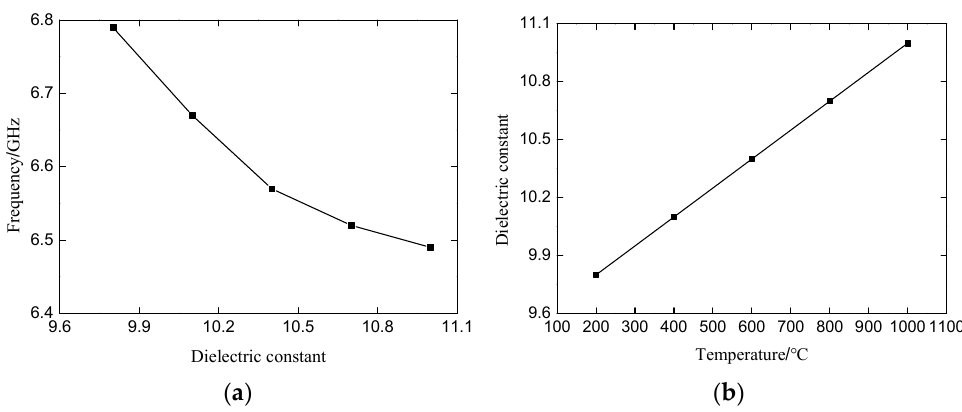
Figure 7. In order to characterize the temperature-frequency characteristics of the sensor, the simulation results are fi(cid:308)ed in two frequency ranges. The corresponding fi(cid:308)ing formulas are selected in different frequency ranges: